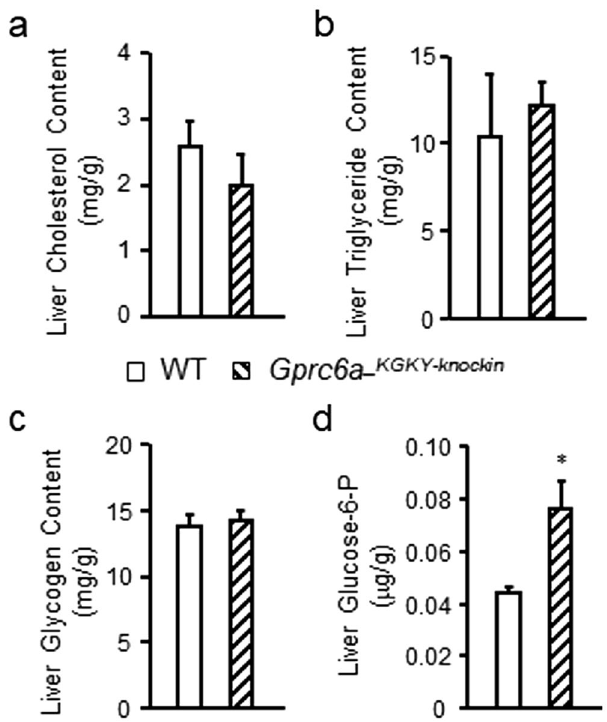
Figure 5. Characterization of additional liver parameters in Gprc6a- KGKY-knockin mice. Comparison of the contents of cholesterol ( a ), triglyceride ( b ) and glycogen ( c ), and glucose-6-phosphate (Glucose-6-P) ( d ) in liver from control group and Gprc6a- KGKY-knokin male mice at age of 10 week-old. Values represent the mean ± SEM. *Significant difference between control group and Gprc6a- KGKY-knockin mice ( P < 0.05, Student’s t test; n =